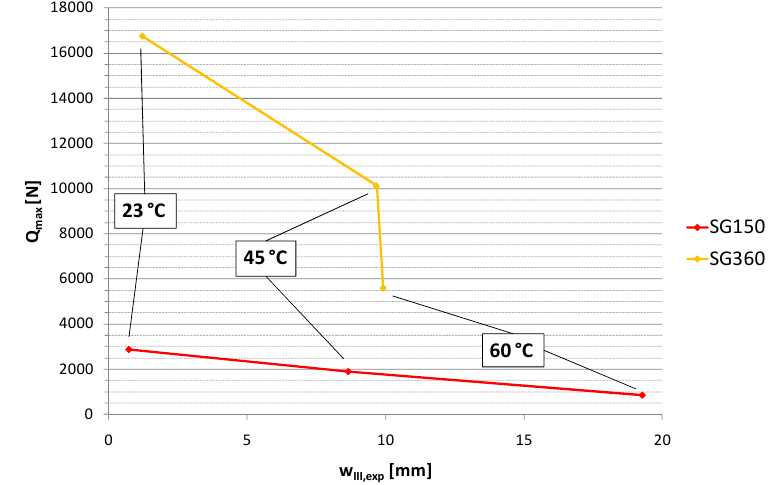
Figure 3: Maximal reached load and corresponding deflection at different temperatures (based on average values by